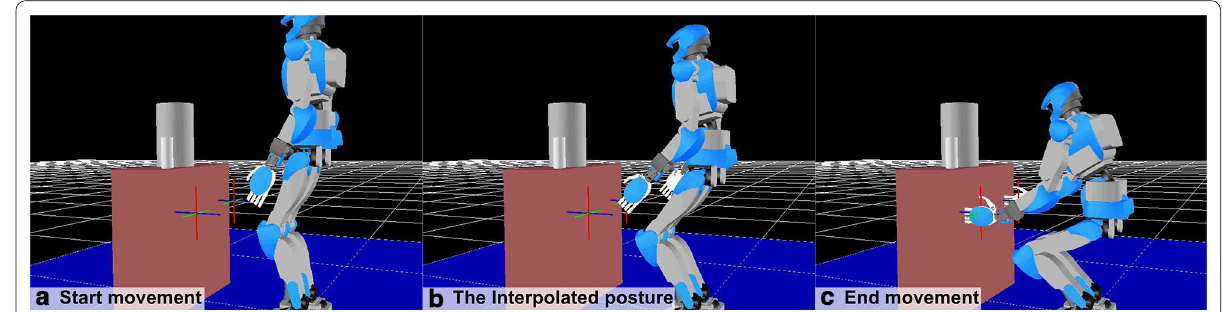
Fig. 9 The posture of HRP-4 generated by the proposed method. HRP-4 completely reaches the target poses (three-colored axes) with the end effectors ( a start movement, b interpolated posture, and c end movement)